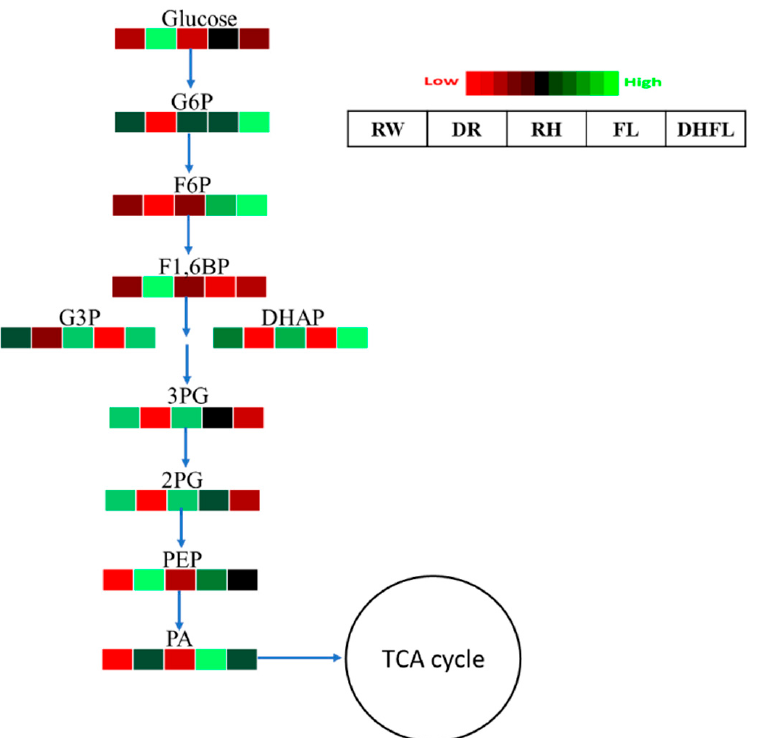
Figure 3. A heat map depicting the individual concentrations of intermediate metabolites of the glycolysis pathway in Mexican mint ( Plectranthus amboinicus ) plants under varying watering regimes (n = 3). Glucose-6-phosphate (G6P), fructose-6-phosphate (F6P), fructose-1,6-bisphosphate (F1,6BP), glyceraldehyde-3-phosphate (G3P), dihydroxyacetone phosphate (DHAP), 3-phosphoglyceric acid (3PG), 2-phosphoglyceric acid (2PG), phosphoenolpyruvic acid (PEP), and pyruvic acid (PA). Metabolite concentrations in each block compartment are normalized across all data for an individual compound such that similar color intensities between compounds can represent widely differing concentrations. The red color represents a lower concentration, and the green color represents a higher concentration of a particular metabolite. The compartment was arranged from left to right as follows: regular watering (RW), drought (DR), resumption of regular watering after drought (RH), flooding (FL), and resumption of regular watering after flooding (DHFL).